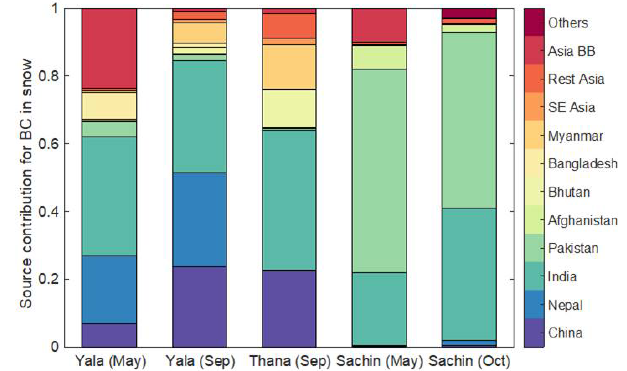
Figure 5. Source contributions to BC content in surface snow from WRF-Chem simulations at the three measurement glacier sites dur- ing the measurement periods. Source regions include anthropogenic emissions from China, India, Nepal, Pakistan, Afghanistan, Bhutan, Bangladesh, Myanmar, southeast (SE) Asia, and the rest of Asia, as well as Asian biomass burning (BB) and BC transported from areas outside the study domain